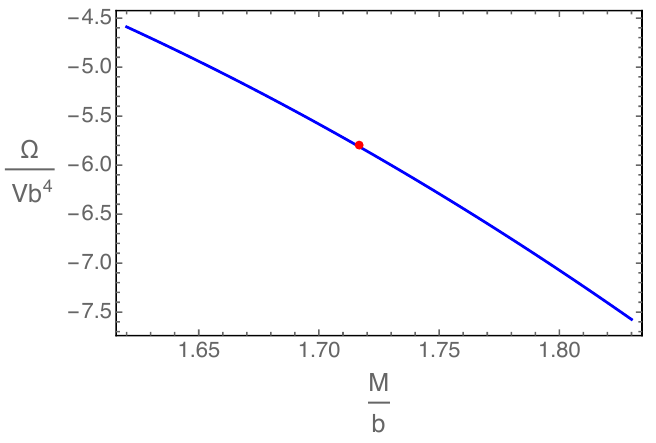
Figure 2 . The bulk pro(cid:12)le for the scalar (cid:12)eld (cid:30) and the two form (cid:12)eld B=f for di(cid:11)erent values of M=b = 1 : 682 (green), 1 : 702 (brown), 1 : 717 (red), 1 : 733 (purple), 1 : 750 (black).